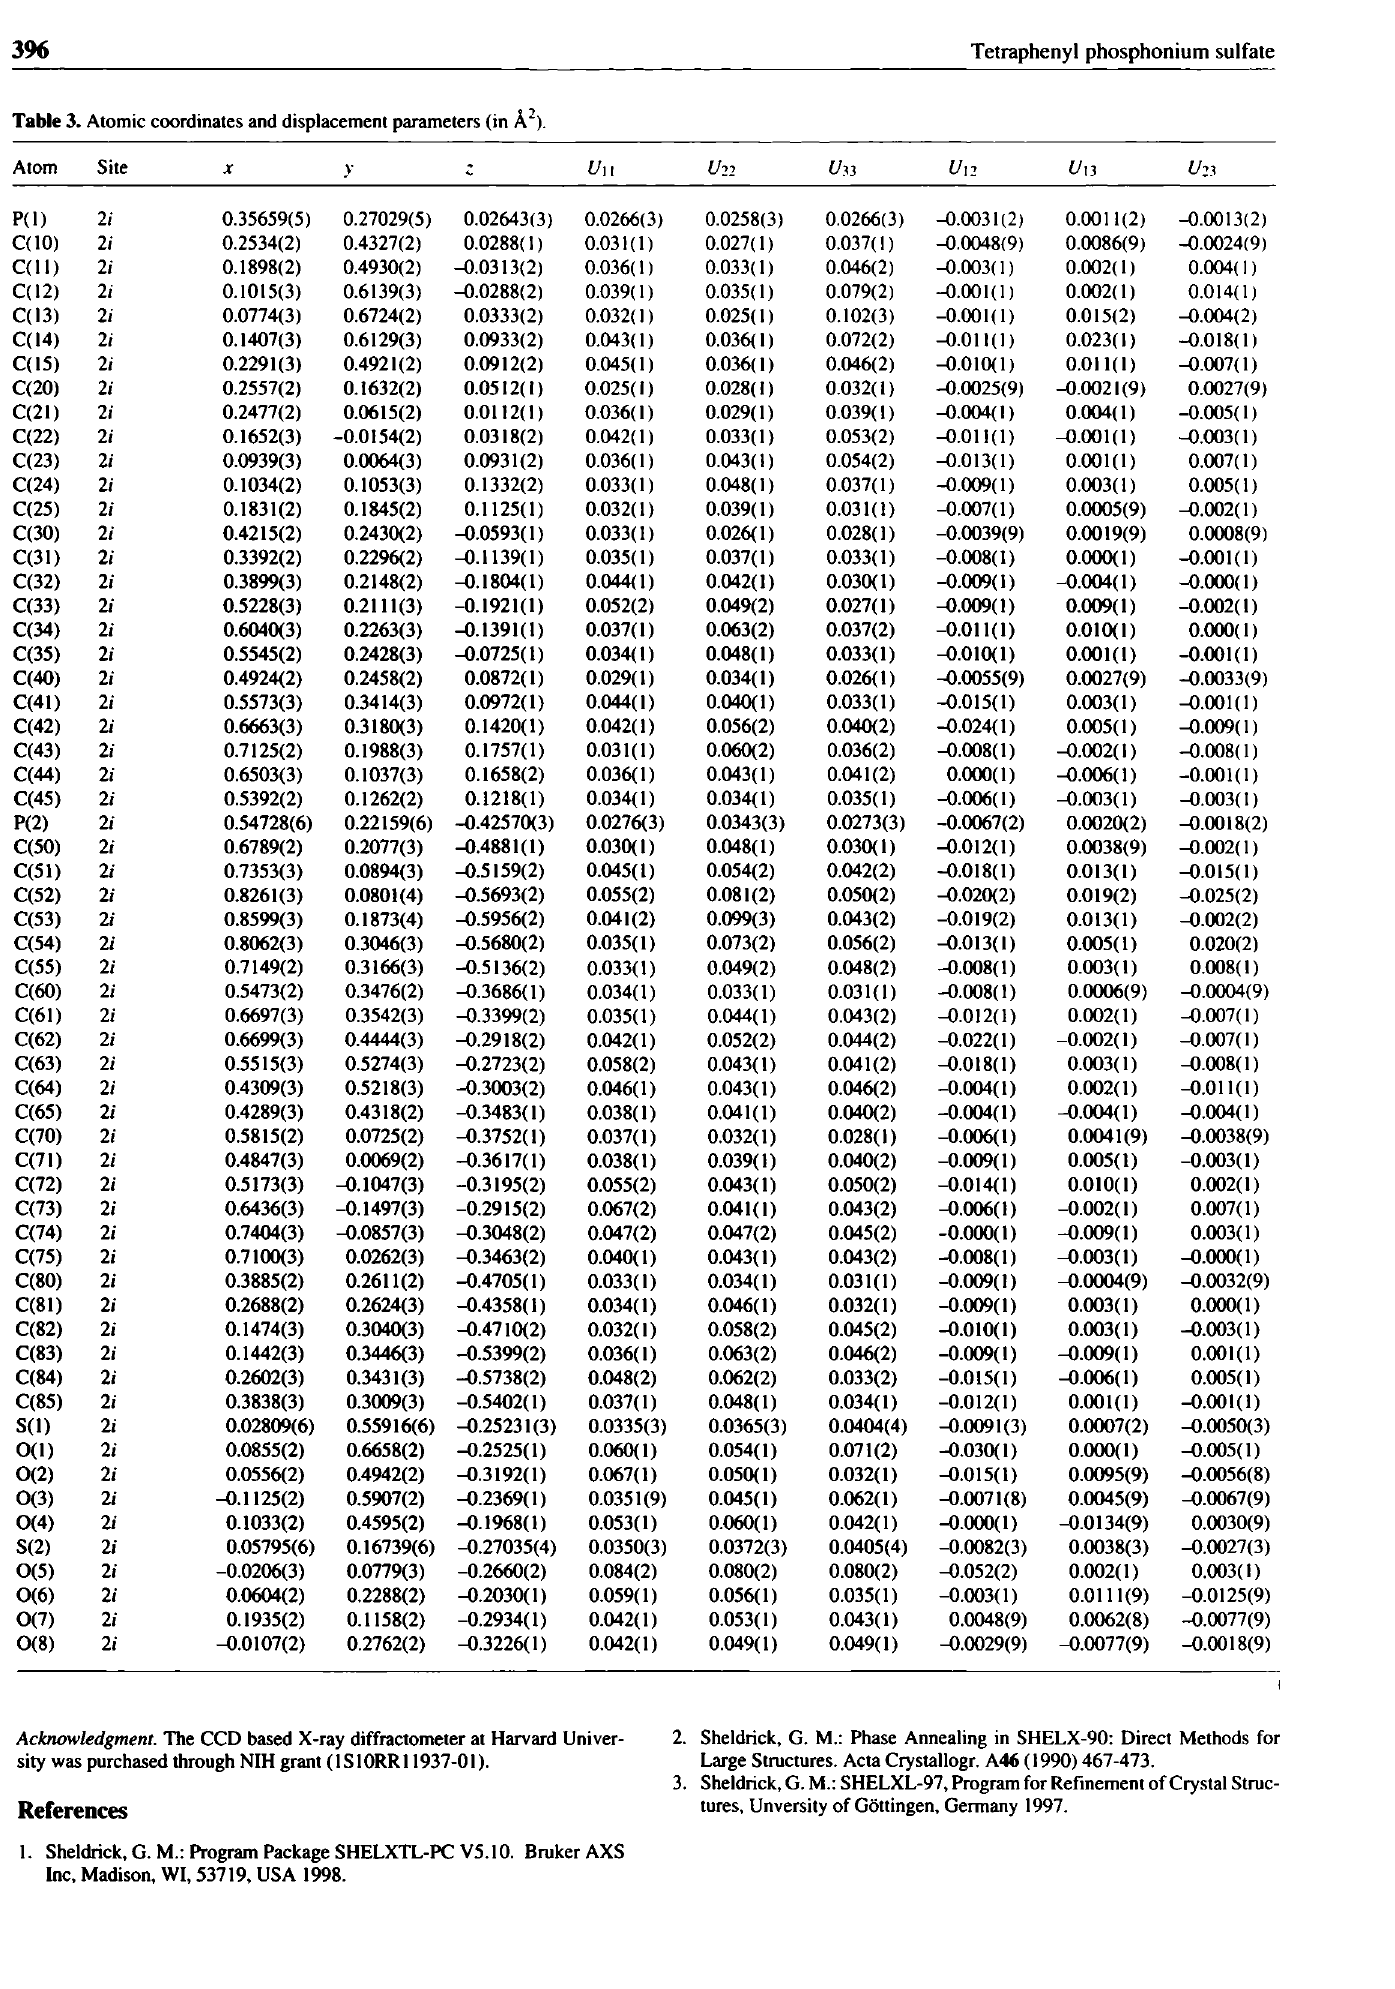
Table 3. Atomic coordinates and displacement parameters (in Ä 2